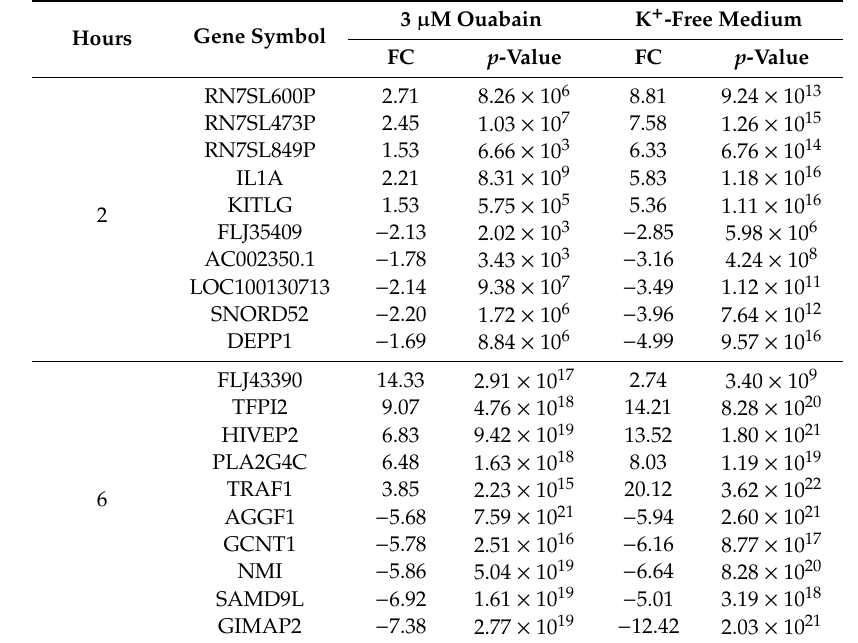
Table 3. Top 10 common di ff erentially expressed transcripts triggered by Na,K-ATPase inhibition by 3 µ M ouabain or K + -free medium in 2 and 6